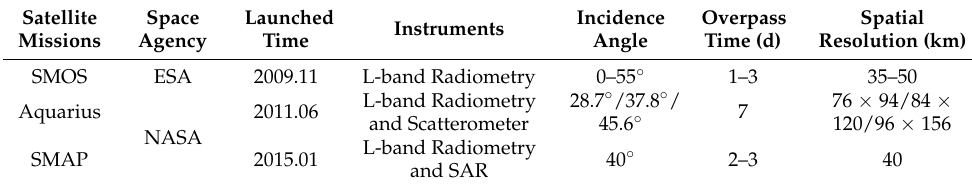
Table 1. Basic information of SMOS, Aquarius, and SMAP